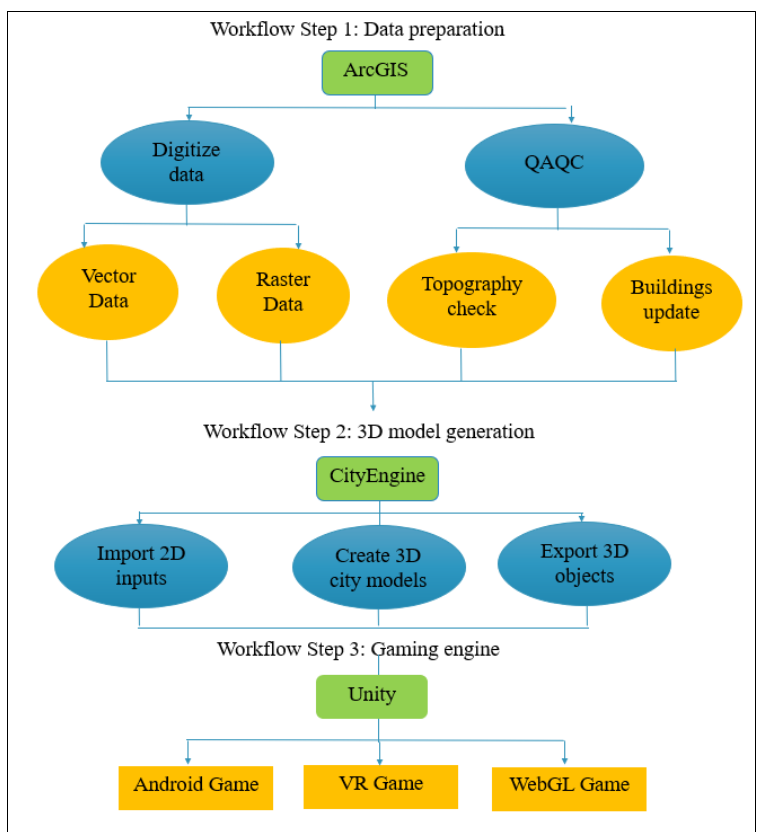
Figure 2. The workflow steps to create a city model from 2D to 3D including data preparation, 3D model generation, and visualization applications.